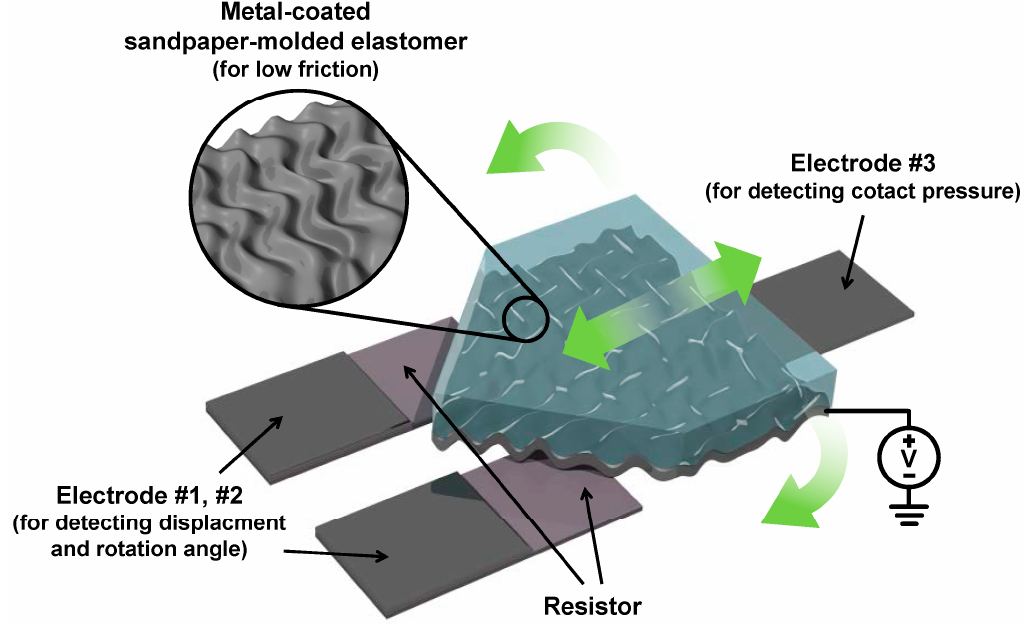
Figure 1. A schematic diagram of the triple contact electrode sensor based on sandpaper-molded elastomer.